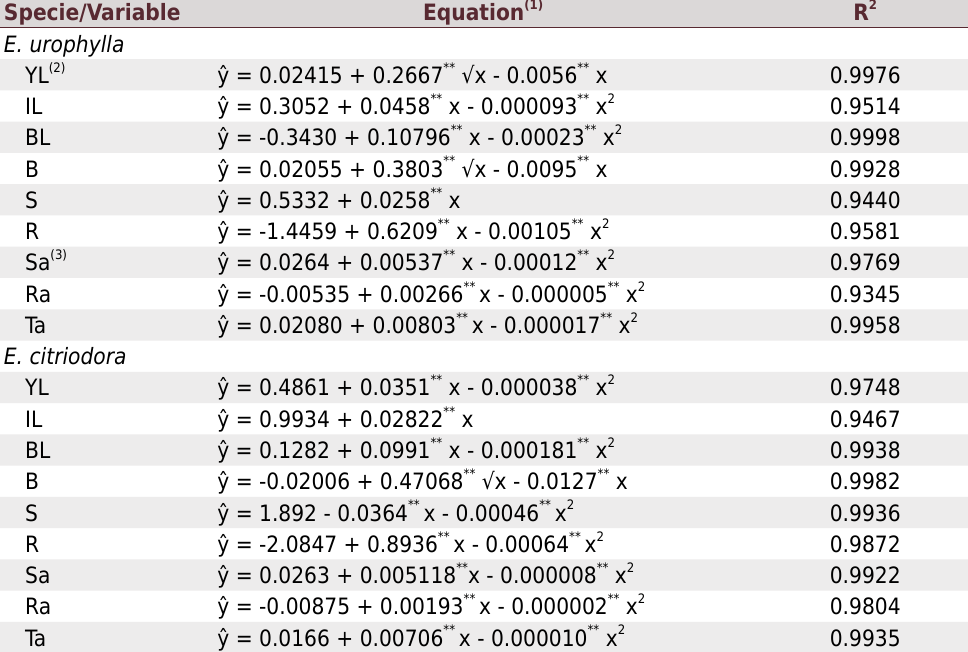
Table 3. Regression equations for arsenic content in young leaves (YL), intermediate leaves (IL), baseline leaves (BL), branches (B), stem (S) and roots (R), and for arsenic amounts in shoots (Sa), roots (Ra) and whole plants (Ta) of E. urophylla and E. citriodora, according to the arsenic rate applied to the soil